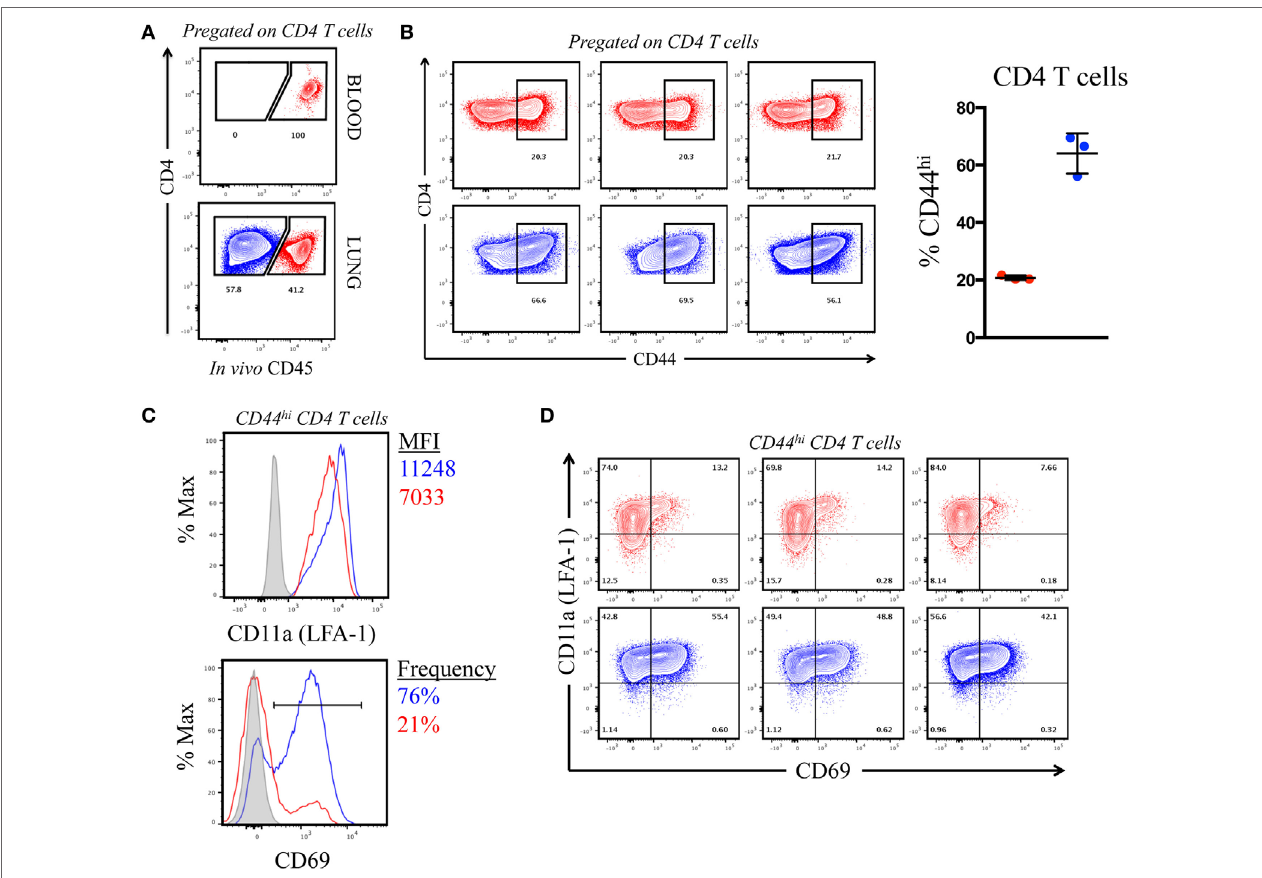
FigUre 5 | Intravenously (IV) labeling reveals distinct compartmentalization and phenotype of pulmonary CD4 T cells following infection. (a) Representative IV CD45-fAPC staining profile from pre-gated, CD4 + T cells in blood and lung following infection, where blue denotes “protected” cells and red denotes “labeled” cells. (b) Contour plots (CD4 vs . CD44) (pre-gated on CD4 + ) and tabulated frequency of CD44 hi CD4 T cells from three individual mice, shown at right. Symbols represent individual animals and error bars reflect standard deviation from the mean. (c) CD11a (LFA-1) MFI,% CD69 + (from CD44 hi CD4 T cells), and expression profile of CD69 vs . CD11a (LFA-1) on IV “labeled” and “protected” cells 10 dpi. Histograms reflect pooled responses from three animals and individual contour plots (D) reflect responses from the three individual